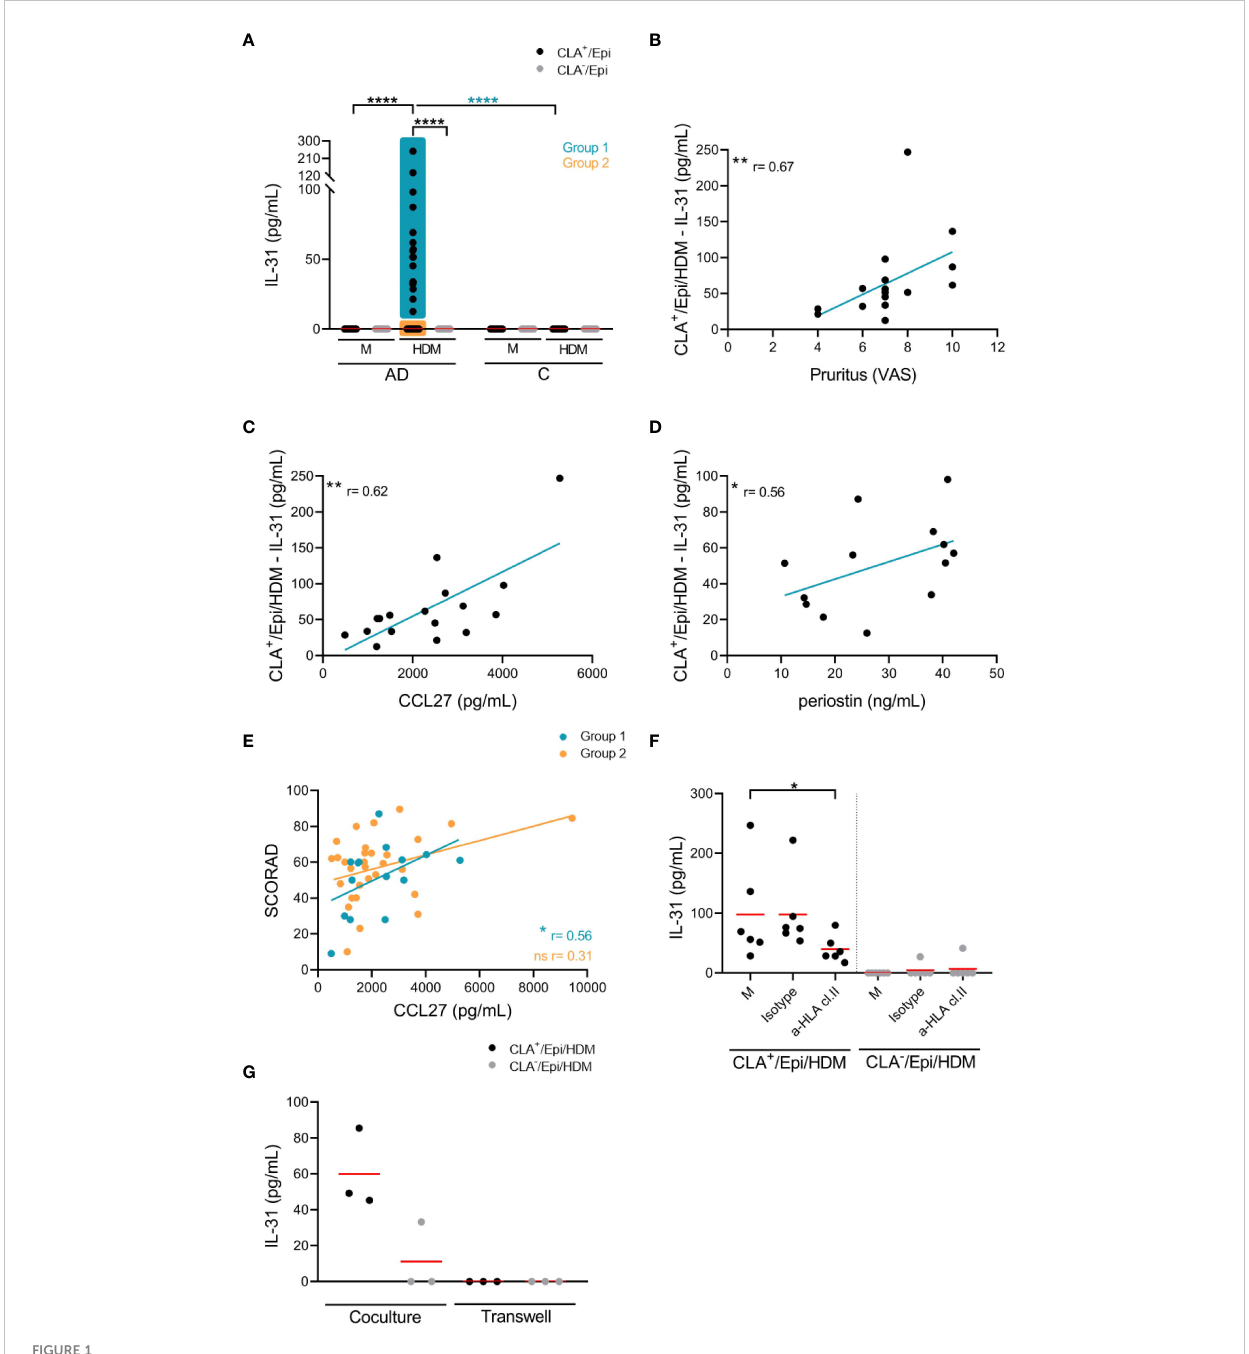
FIGURE 1 HDM-induced IL-31 by memory T cells correlates with patient ’ s pruritus and plasma CCL27 and periostin, partially depends on HLA class II molecules and the cell-cell contact with epidermal cells, and is restricted to CLA + T-cells subset. (A) IL-31 (pg/mL) produced by CLA +/- T-cell cocultures in basal conditions (M) or stimulated with HDM in AD-(n=58) and C-(n=11) derived samples. Correlations of CLA + /Epi/HDM IL-31 production in group 1 with (B) pruritus (n=17), and plasma (C) CCL27 (n=17) and (D) periostin (n=13) levels. (E) Correlation between plasma CCL27 levels and SCORAD in group 1 (n=15) and group 2 (n=31) of patients. (F) HDM-activated CLA +/- T-cell cocultures were treated with HLA class II neutralizing antibody or control IgG isotype at day 0, and IL-31 production (pg/mL) at day 5 was compared with respect to isotype values (n=6). Red bar indicates the mean. (G) CLA +/- T cells were added in the upper chamber and HDM-stimulated epidermal cells suspension in the lower chamber of the 96-well transwell plate and IL-31 (pg/mL) was measured at day 5. Data for three representative patients. AD, atopic dermatitis; C, control subjects; CLA, cutaneous lymphocyte-associated antigen T cells; Epi, epidermal cells suspension; HDM, house dust mite; M, untreated; SCORAD, scoring atopic dermatitis. ns: p >.05; *p <.05; **p <.01; ****p